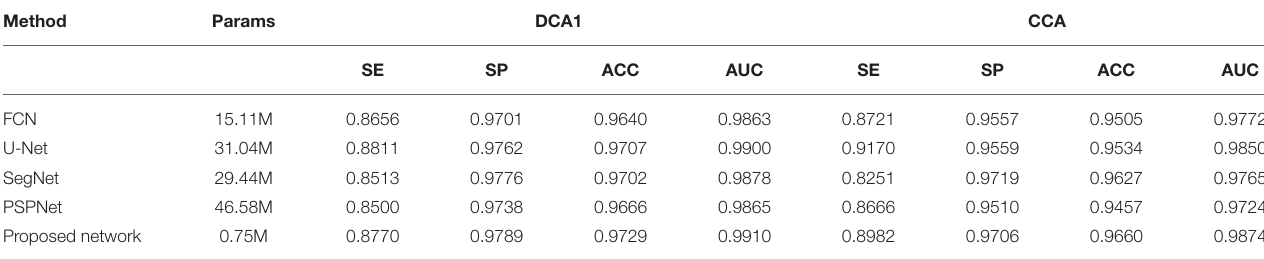
TABLE 9 | Results of the comparative experiments with popular segmentation networks. Method